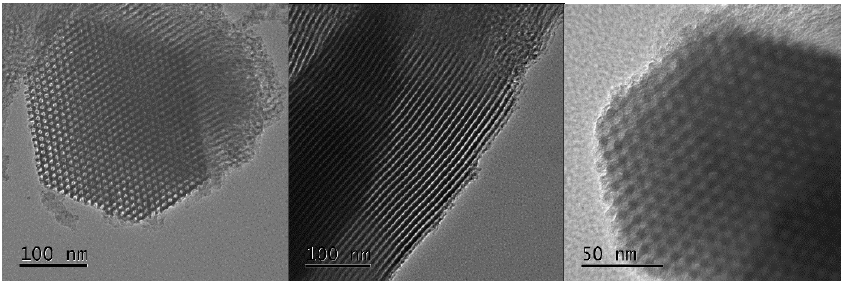
Figure 8. TEM images of the SBA-15 original sample, previously to the NaOH mild hydroxylation treatment, of the S15H hydroxylated specimen.